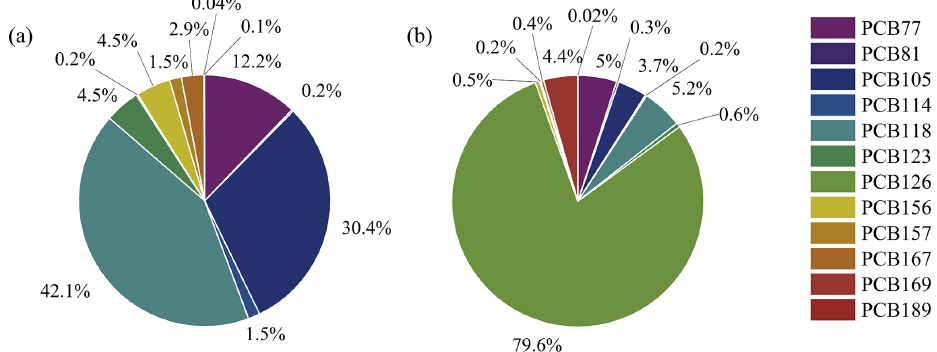
Figure 3. Emission profiles for 12 dioxin-like UP-PCBs in the Chinese mainland in 2019. Pie charts for PCBs congeners in terms of mass (a) and TEQ (b) ,